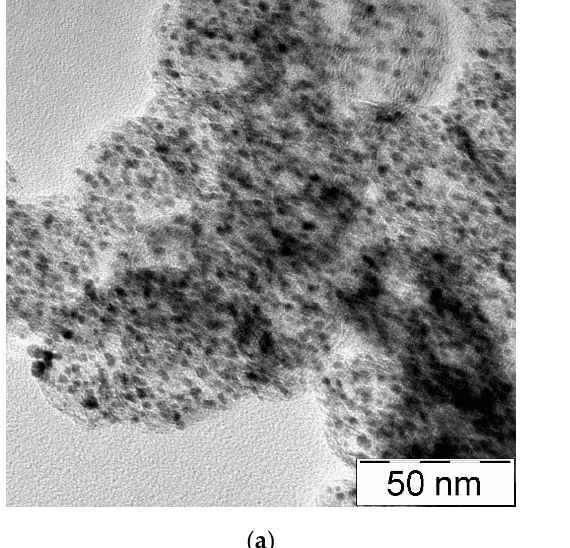
Figure 1. XRD patterns for Pt/KB (lower, black) and PtCo/KB (upper, red) electrocatalysts. TEM images highlight a good dispersion of the Pt particles (Figure 2a) and the metallic PtCo (Figure 2b) alloy on the carbonaceous support. Moreover, the particle size derived from TEM images of 2.8 nm for Pt/KB (Figure 2c) and 3.4 nm for PtCo/KB (Figure 2d) confirm the data obtained from the XRD characterization.